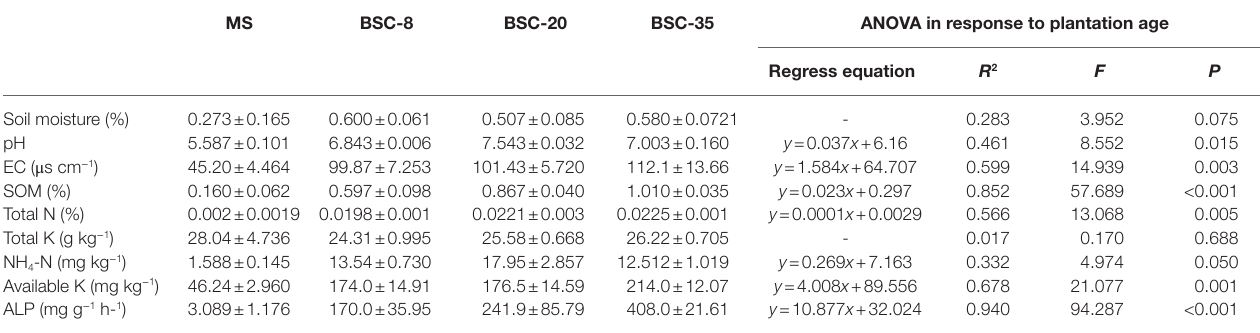
TABLE 1 | Soil properties in an age sequence of soil crusts under